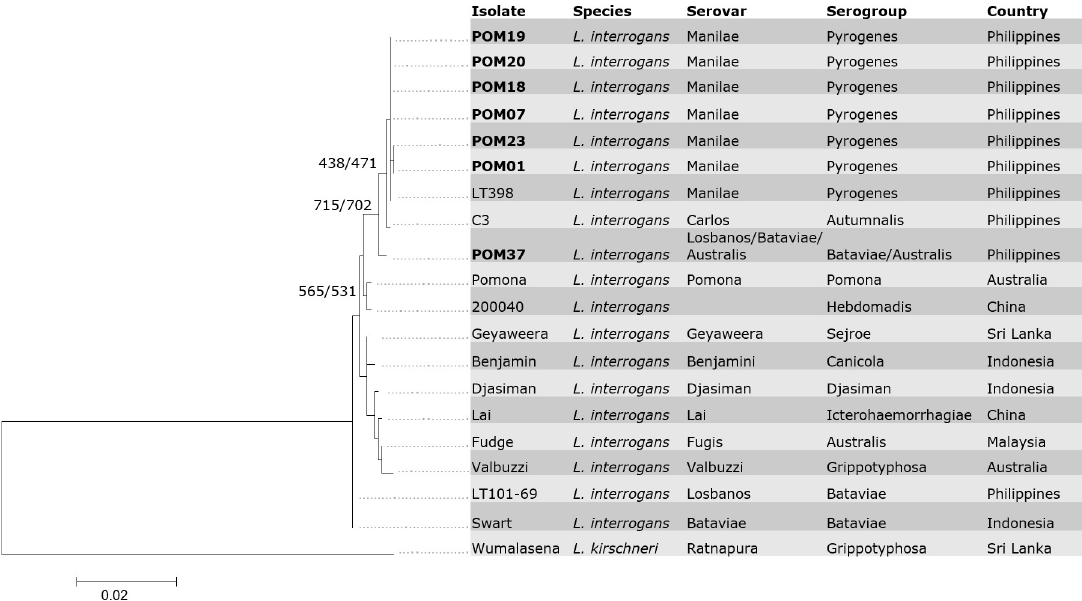
Fig 1. Maximum Likelihood tree of Leptospira inferred from three MLST loci ( adk-lipL41-mreA ) gene sequence alignment (1,357 nt length) based on HKY+G DNA substitution model. Clinical samples (n = 7) are in bold and their corresponding species, serovar, and serogroup assignments are listed. Reference L . interrogans sequences represent 11 serogroups reported in the database (https://pubmlst. org/leptospira/). The tree was rooted with the outgroup, L . kirschneri . Bootstrap values with 1,000 replicates inferred from ML and NJ are shown in the nodes. Scale bar represents 0.02 substitution per site. Corresponding GenBank accession numbers of isolates are provided in S1 Table. Isolate ID of reference sequences from Leptospira PubMLST database are reported in S3 Table.